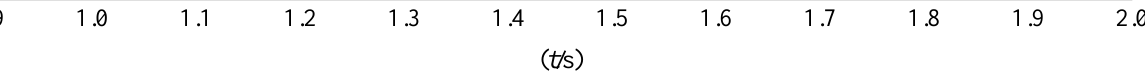
Figure 12. Active current of GSC.